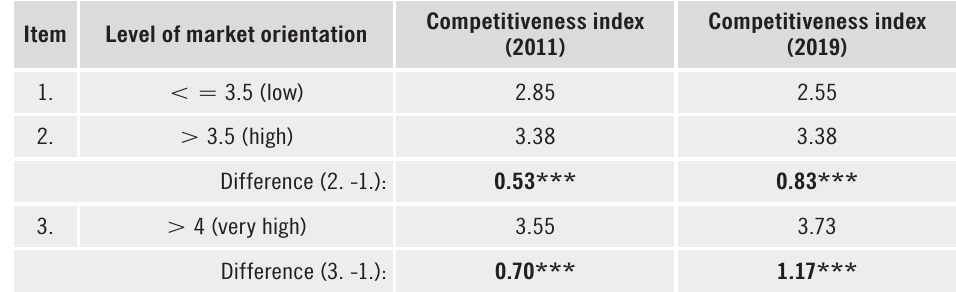
Table 8. Market orientation level compared to the competitiveness index value in high-tech manufacturing companies sampled in 2011 and